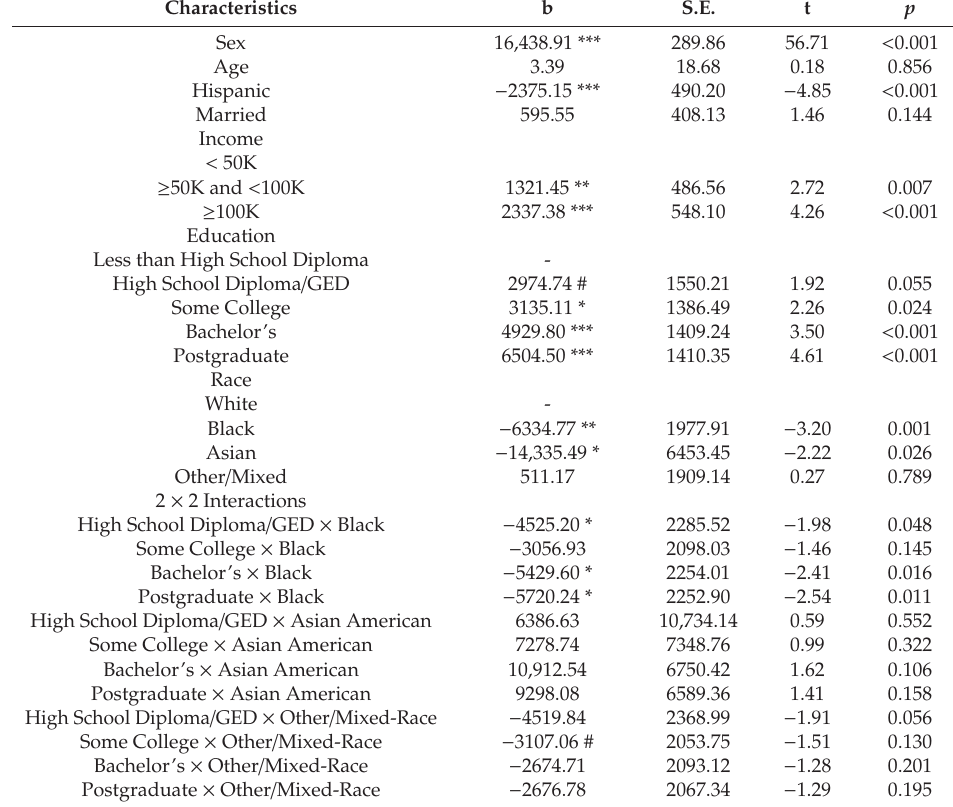
Table 4. Interaction between parental education and race on the whole-brain cortical surface area. Characteristics